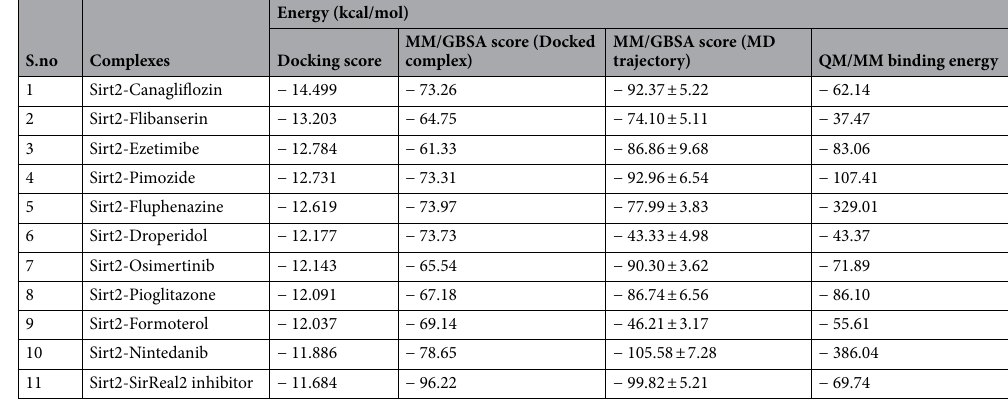
Table 2. Cumulative energy data for the screened drugs and reference inhibitor in the selective pocket of Sirt2